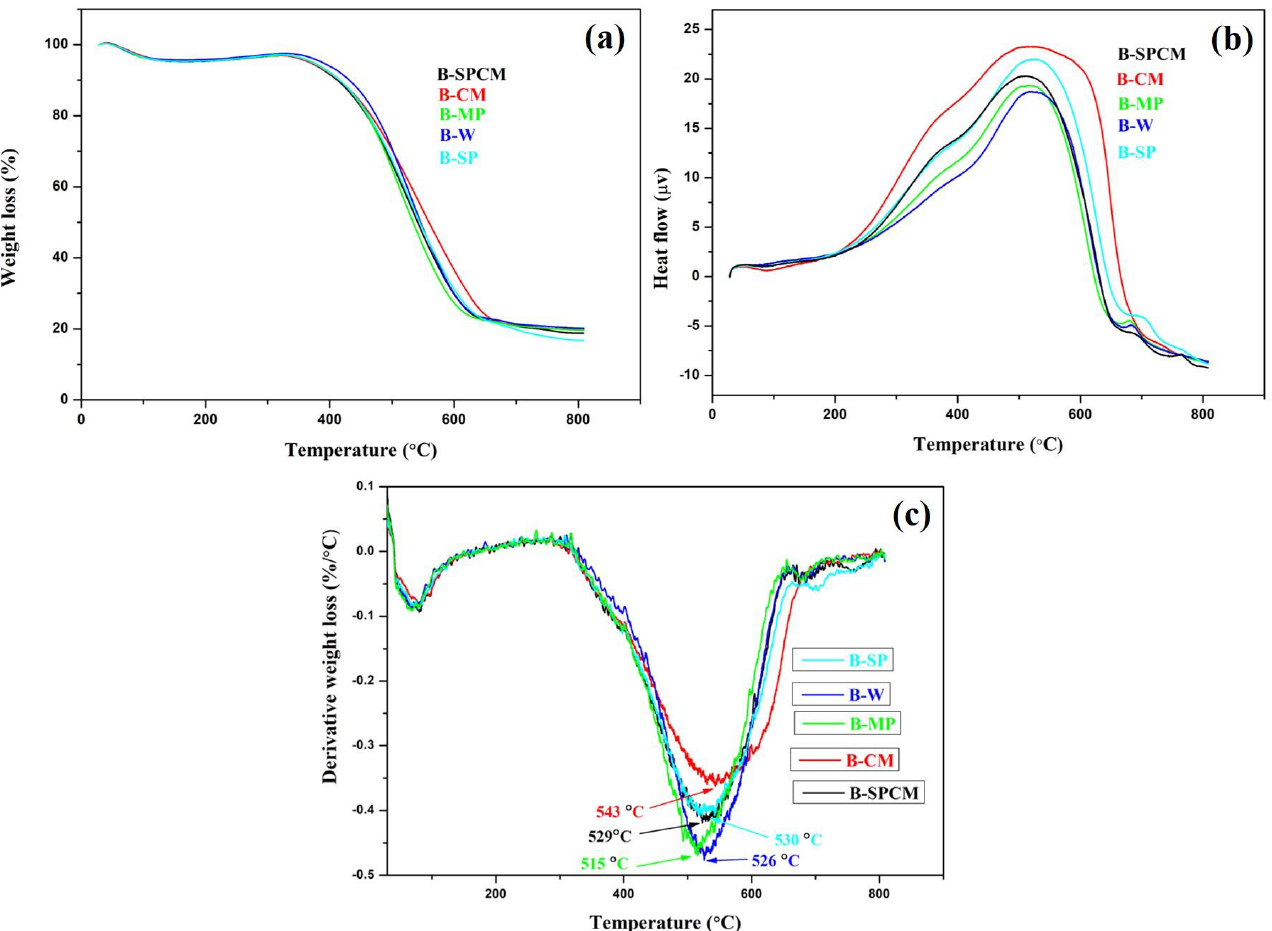
Figure 10. ( a ) TGA, ( b ) DSC, and ( c ) DTG curve of different biochar samples.